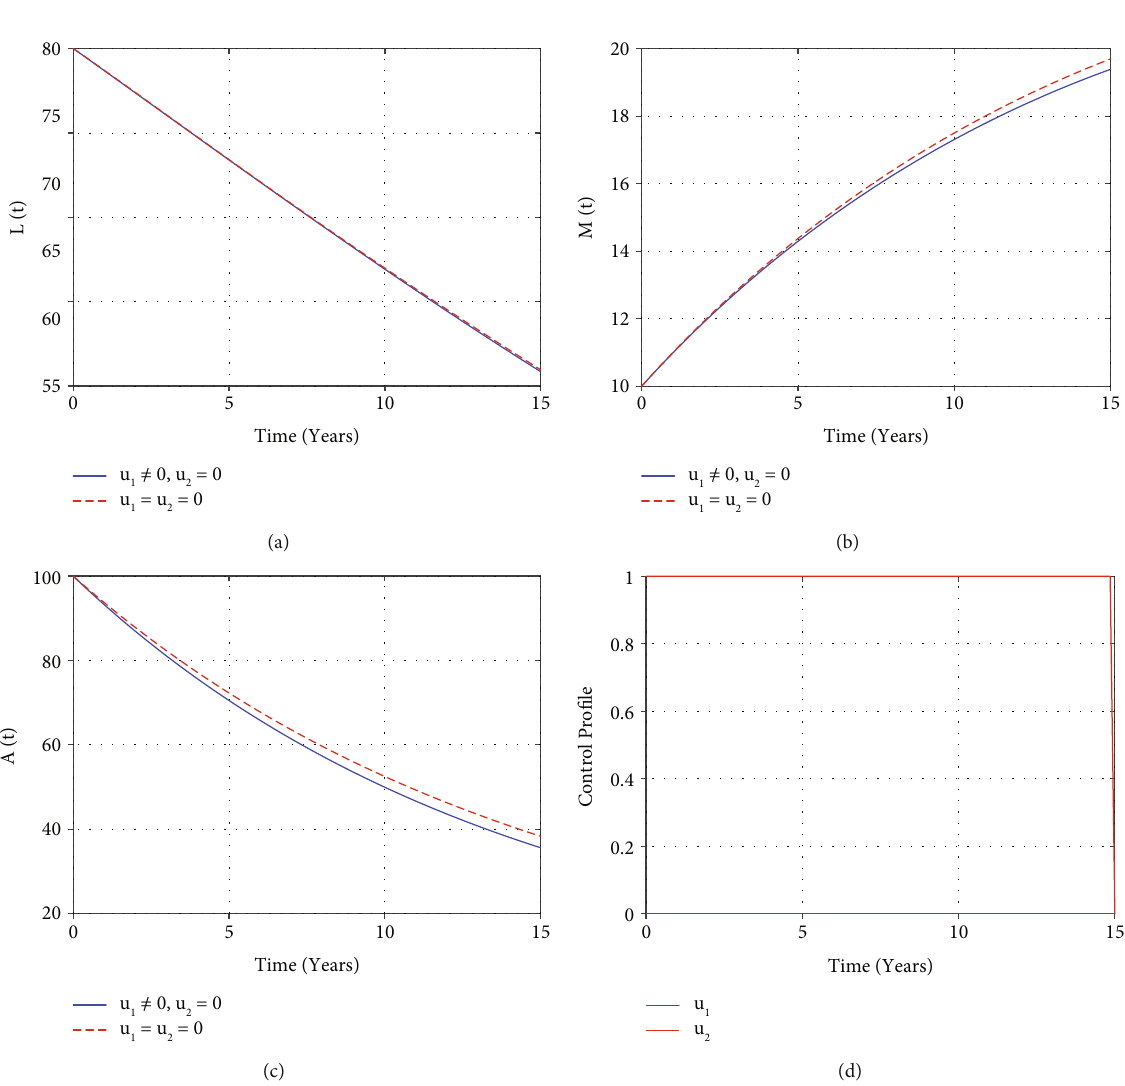
Figure 3: Time series of di ff erent risky population proportions with their corresponding control pro fi le for implementation of Strategy